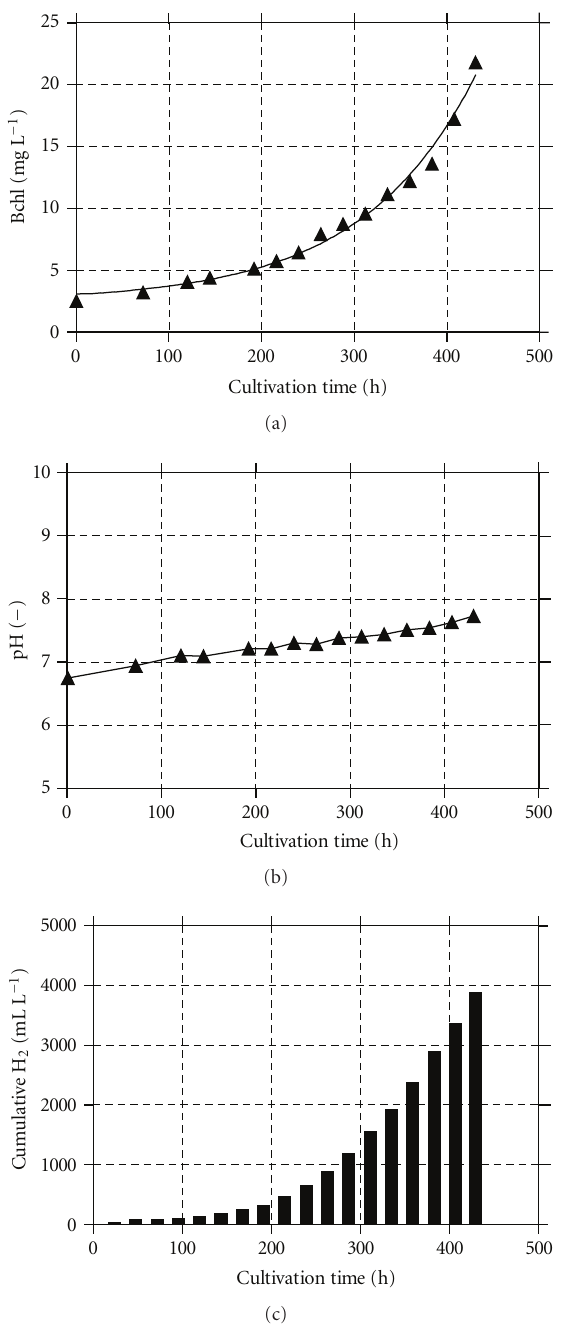
Figure 2: Start-up phase of R. palustris 42OL grown at 30 ◦ C with an irradiance of 480 Wm − 2 . (a) Changes in the Bchl concentration, (b) pH, and (c) cumulative H 2 versus cultivation time.